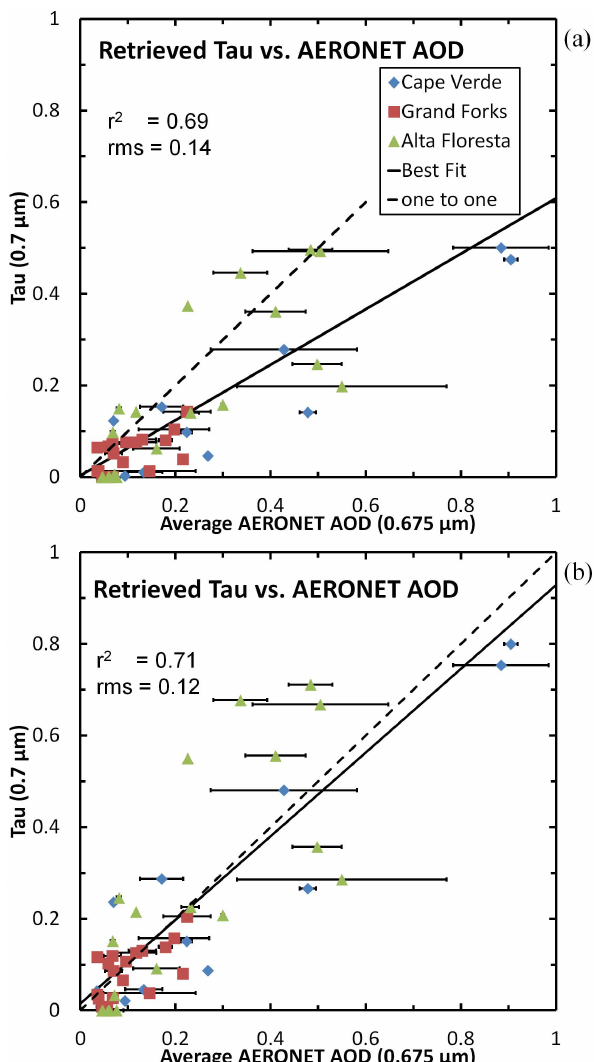
Fig. 4. (a) Scatter plot of estimated AERONET τ (approximated by the nearest daytime observations) versus VIIRS-retrieved τ ig- noring the diffuse transmission of artificial light ( k = 1), and (b) for k estimated with the 6S model using the urban aerosol model for Grand Forks, the desert aerosol model for Cape Verde, and the biomass burning aerosol model for Alta